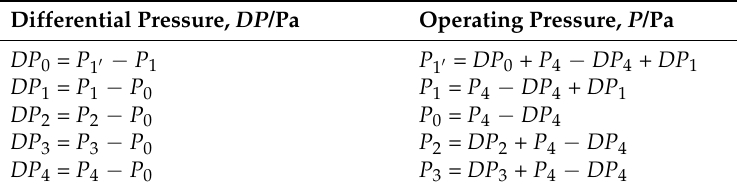
Table 1. Calculations of pressures at different pressure ports.